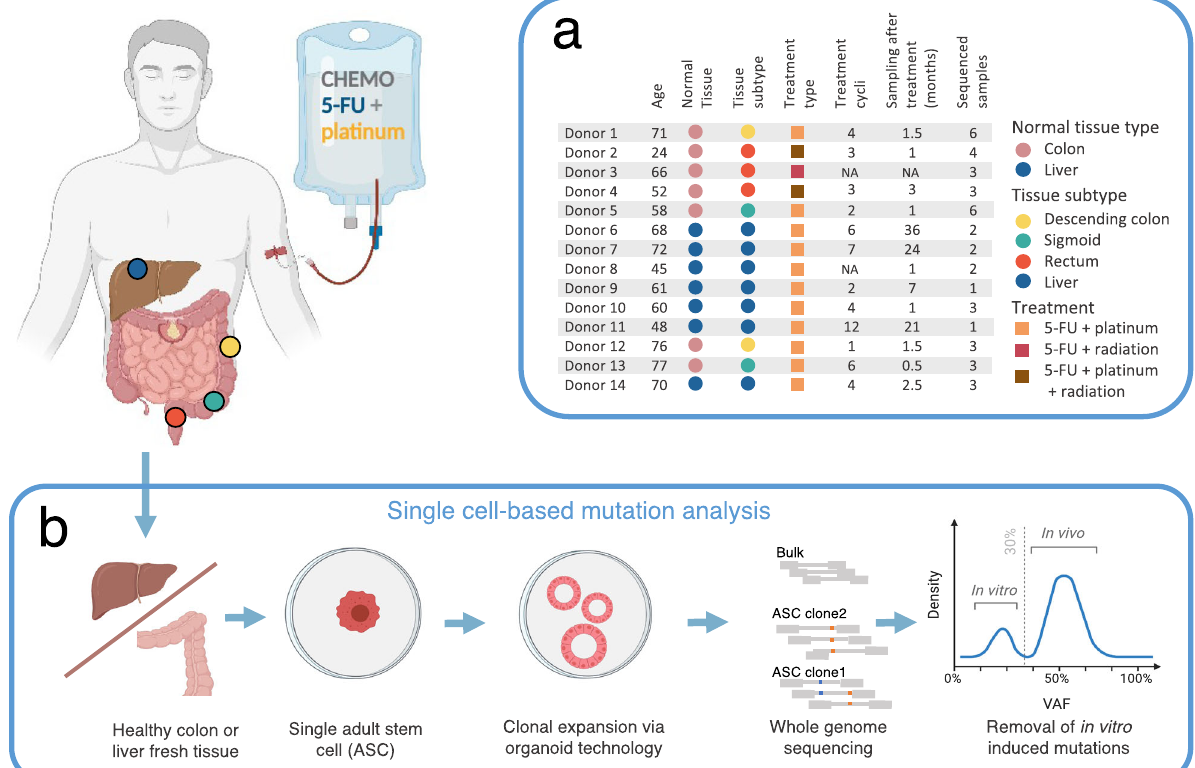
Fig. 1 | Experimental design. a Clinical overview of the 14 treated donors used in this study. The table describes the pathological details, treatment history and the number of adult stem cell (ASC) samples analyzed per donor. b Schematic of the experimental setup to determine genome-wide somatic mutations in individual healthy colorectal and liver ASC from patients who have received CapOx che- motherapy and/or radiotherapy treatment. For this, fresh colorectal and liver normal tissue wasderived from the resection margin around the colorectaltumor during surgical removal of respectively primary colorectal tumors or colorectal tumors metastasized to the liver to derive healthy colon or liver tissue, respec- tively.Subsequently, fresh healthytissue wasminced, dissociated into singleadult stem cells (ASCs) solutions and in vitro expanded into clonal organoid cultures to